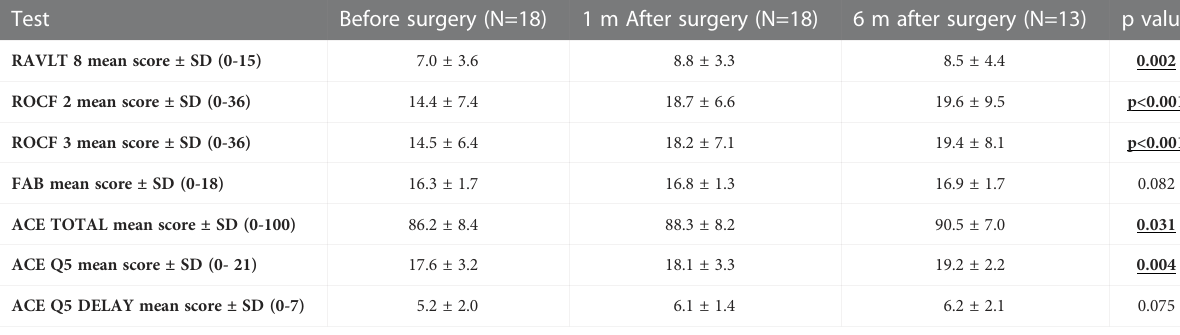
TABLE 2 Mean scores before and after parathyroidectomy, improvement is score elevation.